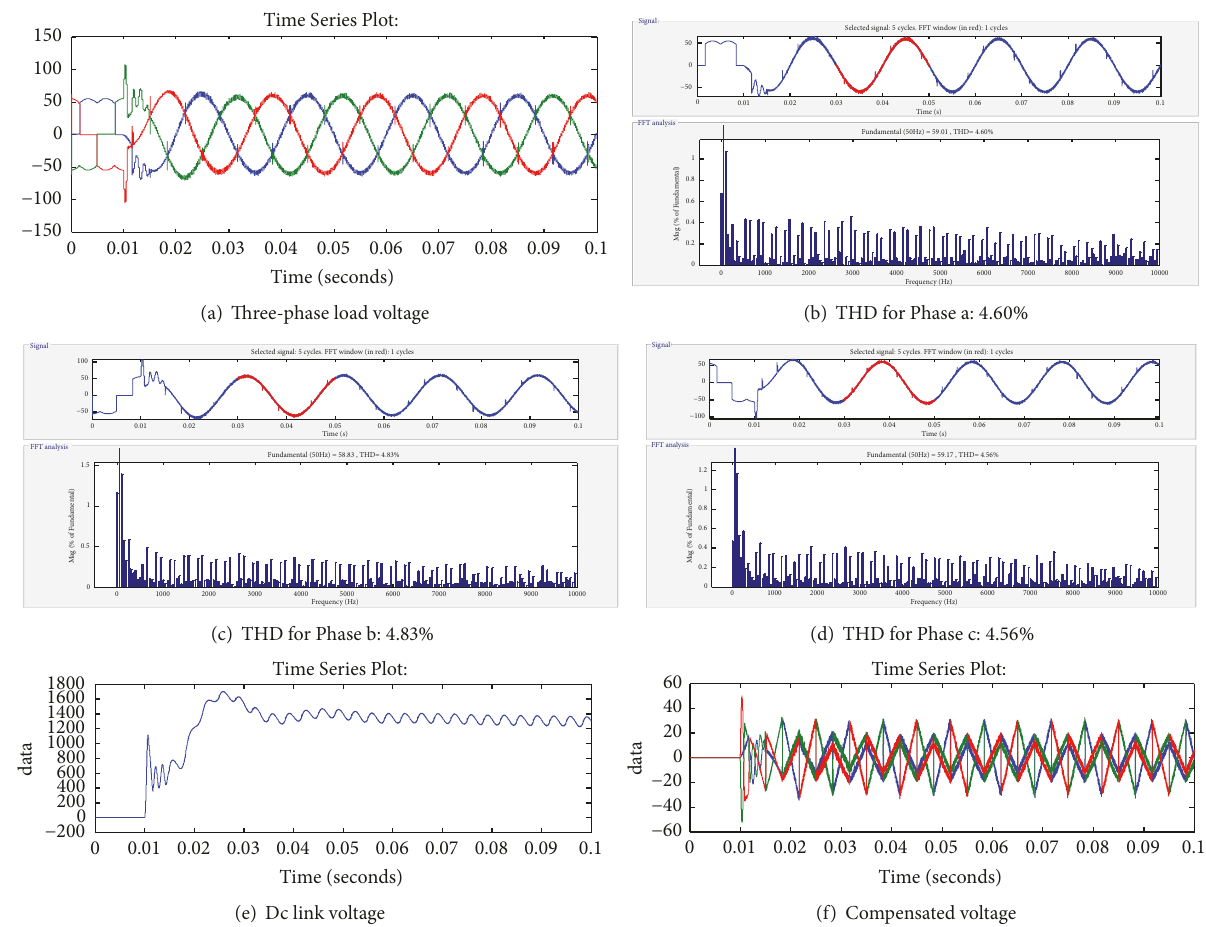
Figure 7: Performance of load voltage and THD values of three-phase voltages and dc bus voltage and compensation voltage using HCC.